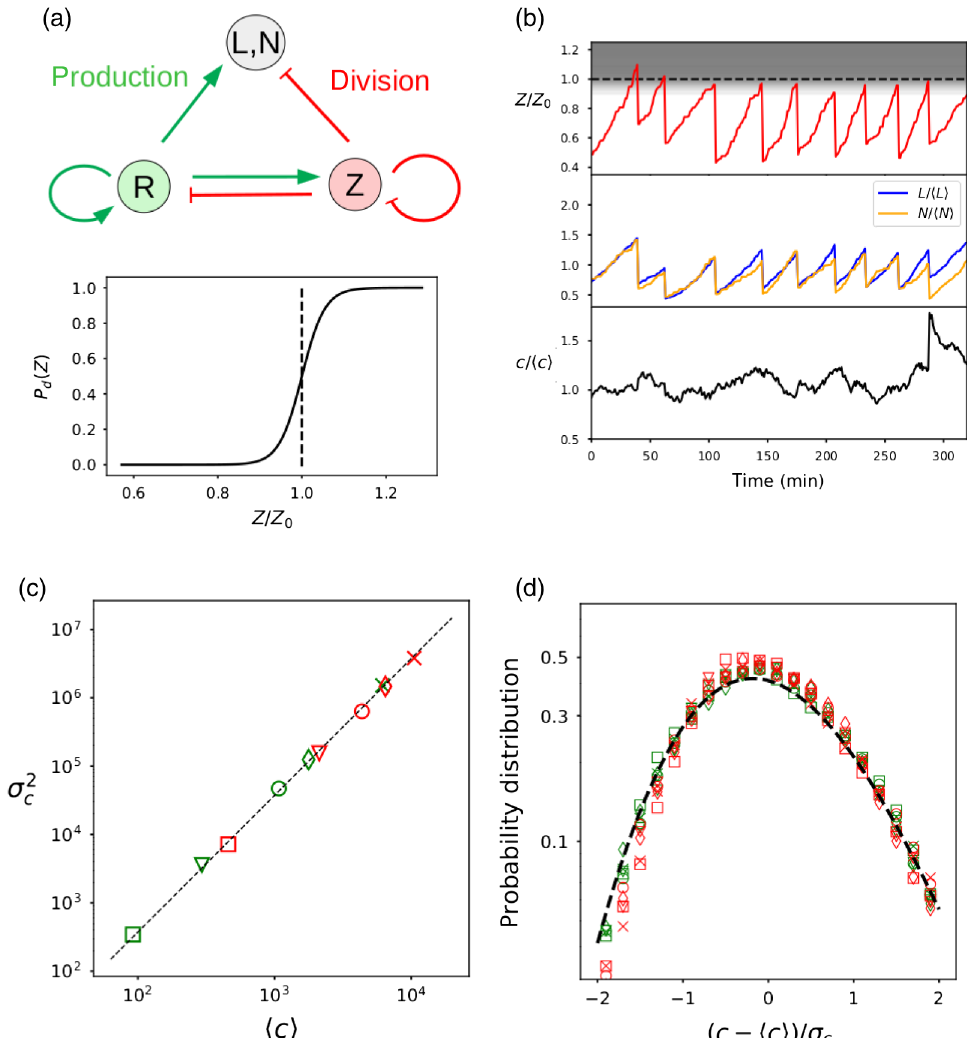
FIG. 5. The minimal mechanistic model and its behaviors. (a) Top: illustration of the four-node model. All production (growth) processes (green arrows) depend on R . The division process, which reduces all variables (red lines), is controlled by Z . Bottom: the Z Þ as a function of the division protein number Z . (b) Time traces of normalized division protein (red), probability rate of division P d ð protein number N (orange), cell size L (blue), and protein concentration c ¼ N=L (black). In the top, we show in gray the region where the division probability is large (the dotted line is for Z ¼ Z 0 ). (c) Variance of the concentration versus its mean from our model for different promoters (different symbols) and under different nutrient conditions (green, rich medium; red, poor medium). The same symbols and colors are used as experimental data shown in Fig. 2(a) for easy comparison. (d) Distributions of the normalized fluctuations in the concentration obtained with the same parameters as in (c) collapse onto the same curve. The dashed line is from Z Þ are Δ Z=Z 0 ¼ 2 . 7 × 10 − 2 and Δ t ¼ 2 min. the analytical expression Eq. (13) obtained from our model. The parameters for P d ð See Appendix B for details of the simulations and parameters